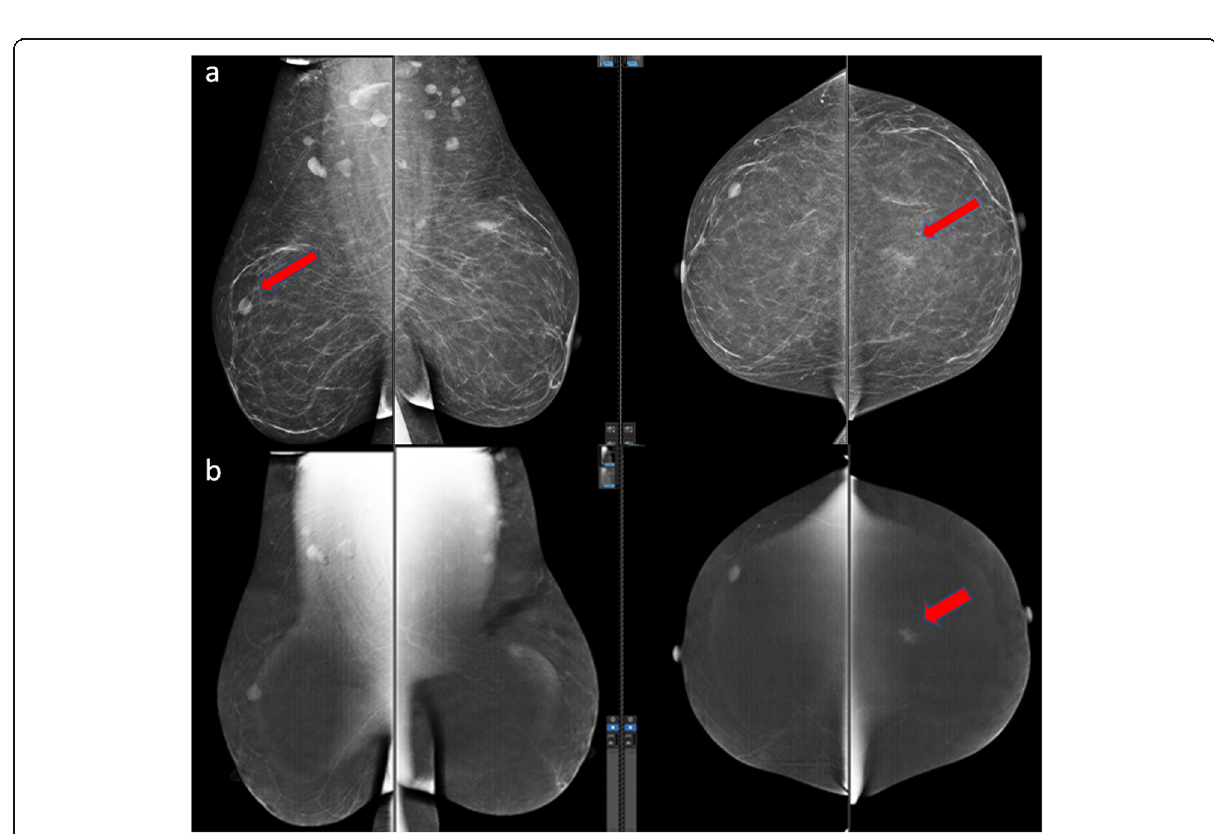
Fig. 1 A 49-year-old female coming for screening with history of hormonal contraception intake. a FFDM showed scattered fibro-glandular densities (ACR B), right oval-shaped well-circumscribed lesion ( BIRADS 3 ) and left focal asymmetry with underlying subtle irregular-shaped lesion ( BIRADS 4 ). b CESM showed homogeneous enhancement of the right breast lesion ( BIRADS 2 ) and heterogeneous enhancement with spiculated margins of the left breast lesion ( BIRADS 5 ). Histopathology : left breast IDC; US with follow-up: right breast small adenoma. Comment : CEM confirmed the malignant and benign nature of both lesions seen on mammography